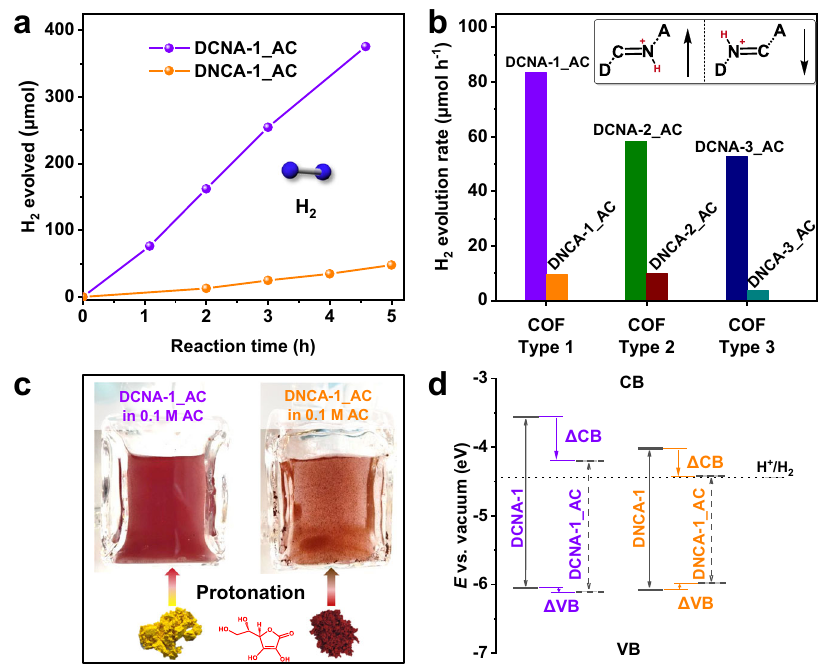
Fig. 4 | Photocatalytic HER performance of the isomeric COFs. a The HER evo- lution of the isomers DCNA-1_AC and DNCA-1_AC using AC as sacri fi cial electron donor (3mg catalyst, 16mL 0.1molL − 1 (M) AC aqueous solution, 3 µ L H 2 PtCl 6 (8wt.%inwater), λ > 420nm,20°C). b ComparisonofthephotocatalyticHERrates